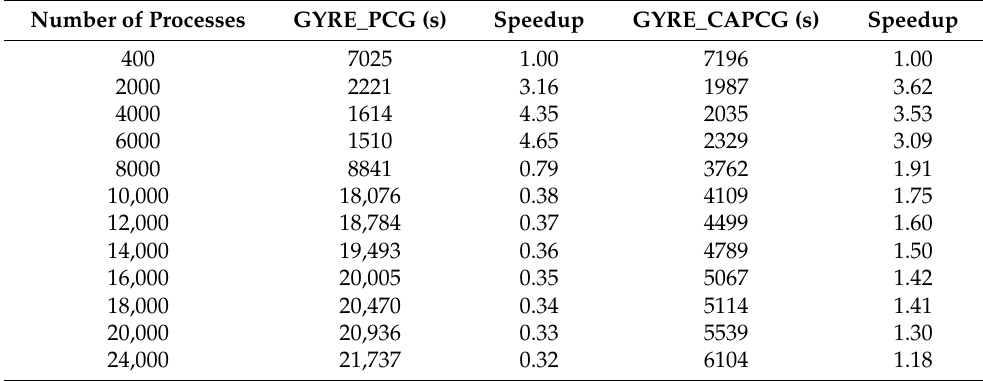
Table 1. Execution time for the high-resolution